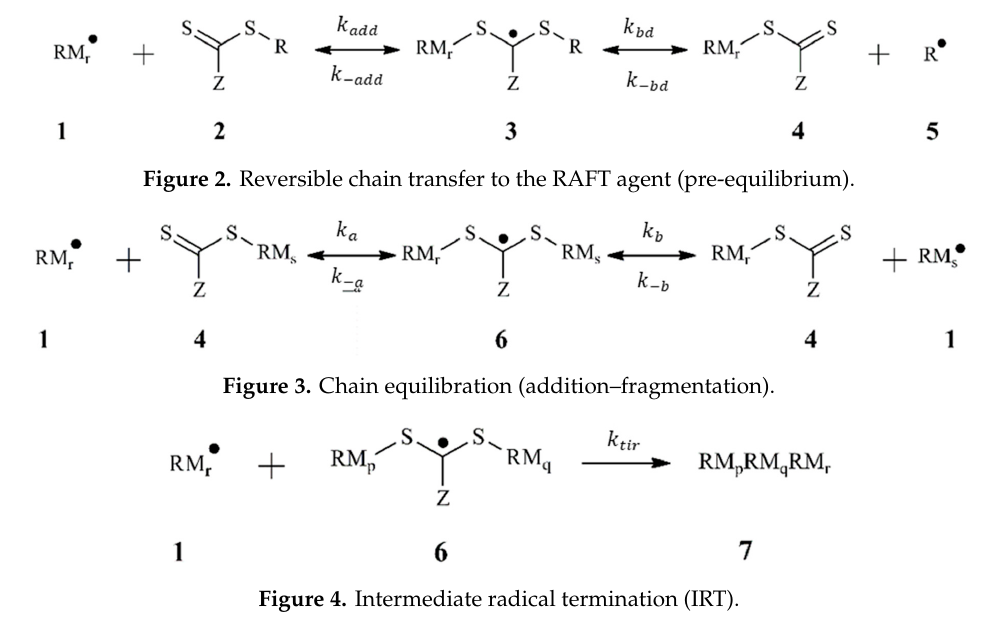
Figure 1. General chemical structure of a reversible addition–fragmentation chain-transfer (RAFT) agent (denoted as AB in the modeling equations below).